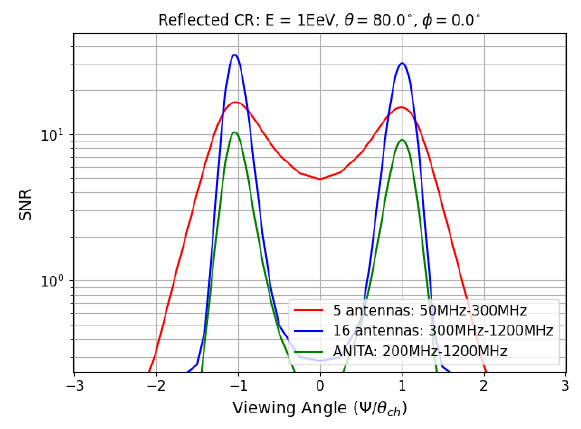
Figure 4. Frequency integrated SNR of a re fl ected cosmic ray event as a function of viewing angle for the LF instrument com- pared against PUEO’s main instrument. The same curve is also plotted for the ANITA-IV antenna for comparison.